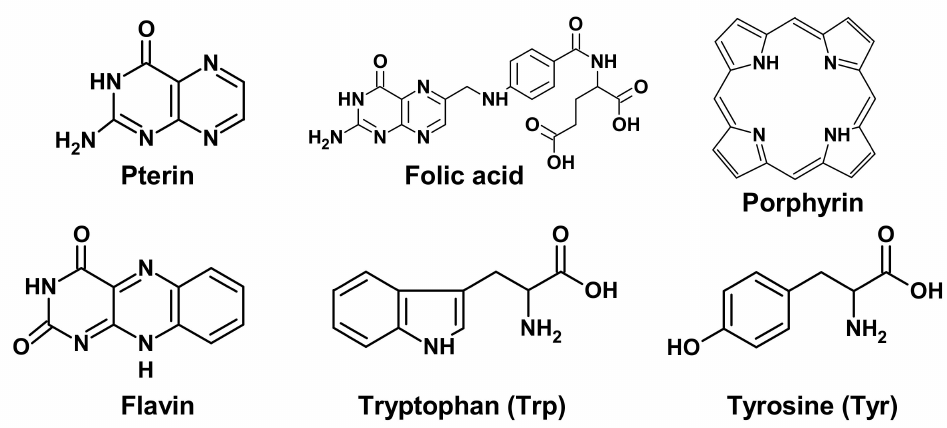
Figure 1. Chemical formulas of low molecular weight biological